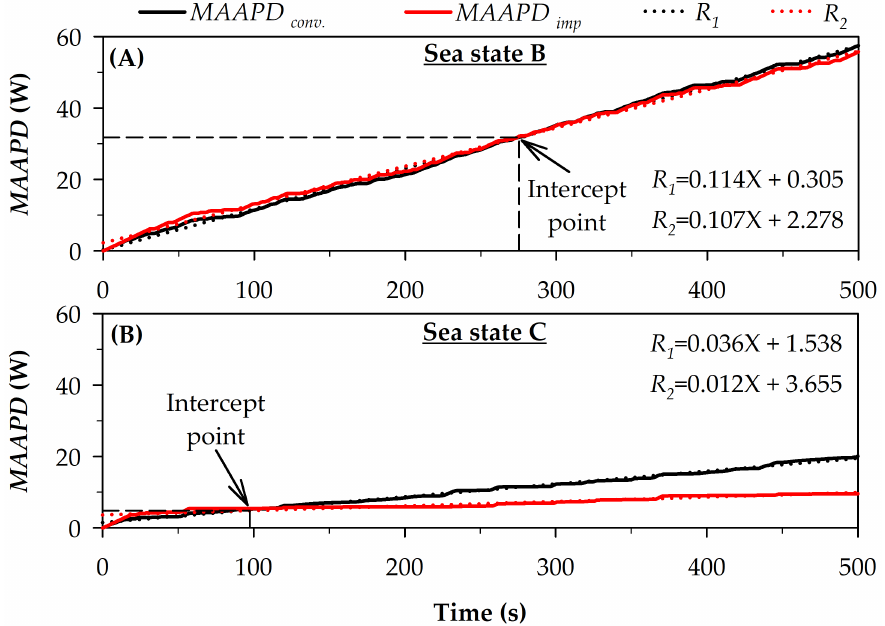
Figure 21. A comparison of MAAPD for conventional and improved HPTO unit models for the different significant wave height cases.